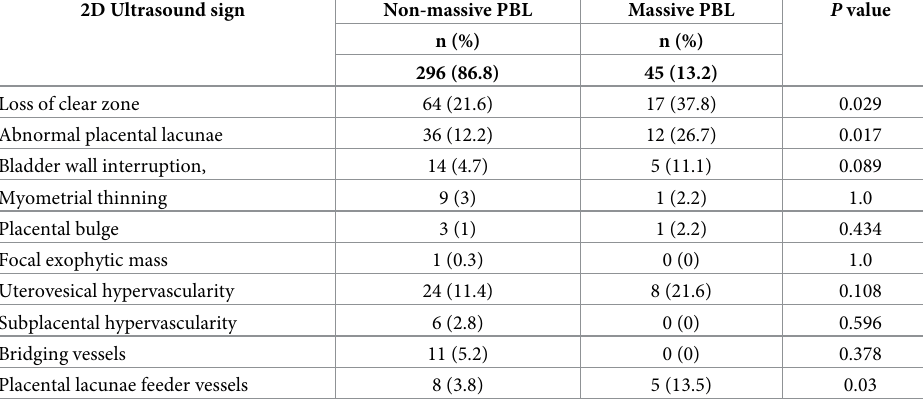
Table 3. Ultrasound signs as predictors of massive blood loss in placenta previa without